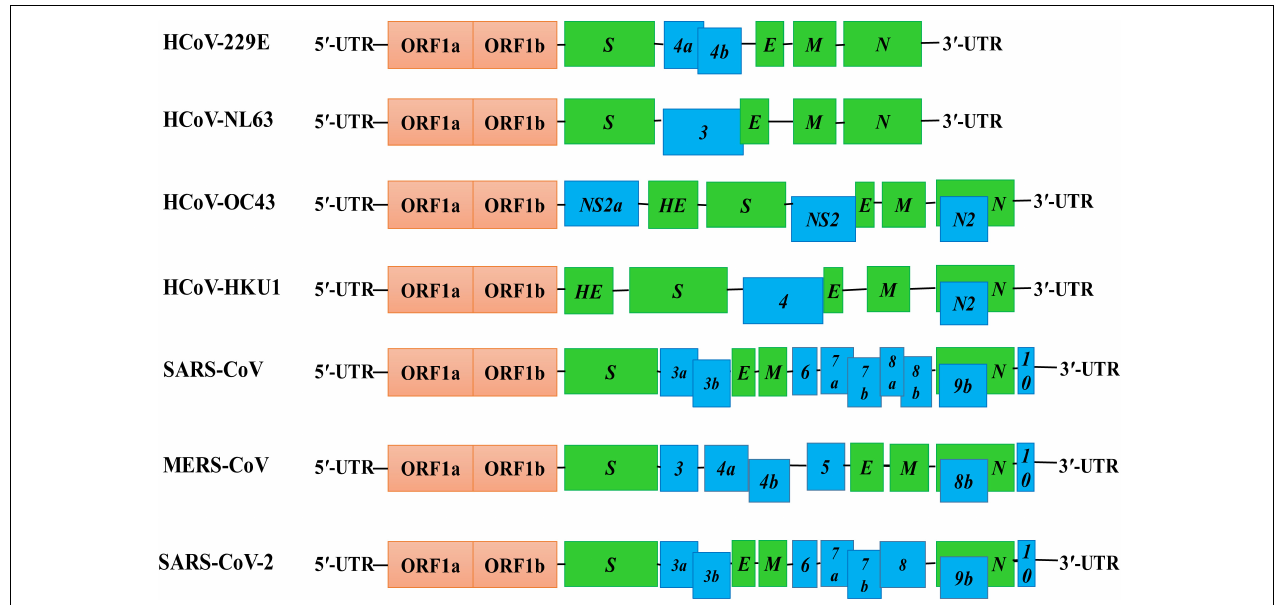
FIGURE 3 | Genome structures of SARS-CoV-2 and other HCoVs. The schematic diagram shows the genome structure of seven HCoVs [the non-structural proteins’ (nsps) and open reading frames’ (orfs) lengths are not drawn in scale]. The 5 (cid:48) -UTR and 3 (cid:48) -UTR are indicated. The polyprotein with open reading frame 1a (ORF1a) and ORF1b are shown as red boxes. The genes encoding structural proteins spike glycoprotein (S), envelope (E), membrane (M), nucleocapsid (N), and hemagglutinin-esterase (HE) are indicated as green boxes. The genes encoding accessory proteins such as ORF 3a/b, 4a/b, 5, 6, 7a/b, 8a/b, 9b, and 10 are indicated as blue